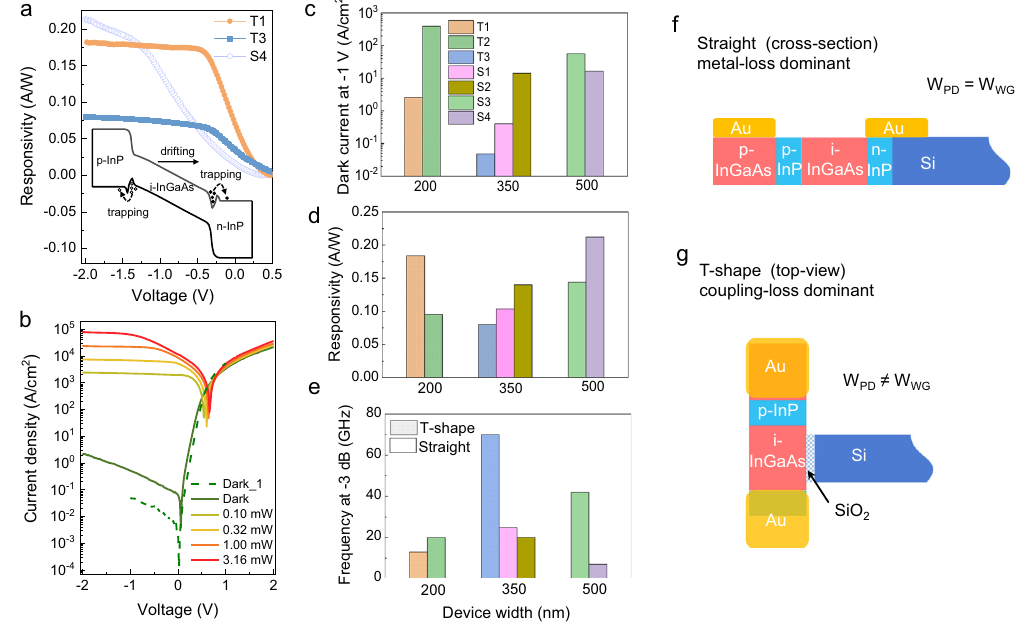
Fig. 5 Static characterization of the p-i-n photodetectors. a Responsivity of T1, T3 (T-shape), and S4 (straight), inset: energy band diagram of the p-i-n device. b I – V curves of T3 without light (dark green) and with 1320 nm waveguide coupled laser power varying from 0.1 mW to 3.16 mW. c Dark current (at − 1 V) dependence on device architecture and device width. d Responsivity (at − 2 V) dependence on device architecture and device width. e f dependence on device architecture and device width. f Schematic of the cross-section of a straight device, W PD is the device width and W WG is the Si waveguide width. g Schematic of the top-view of a T-shape